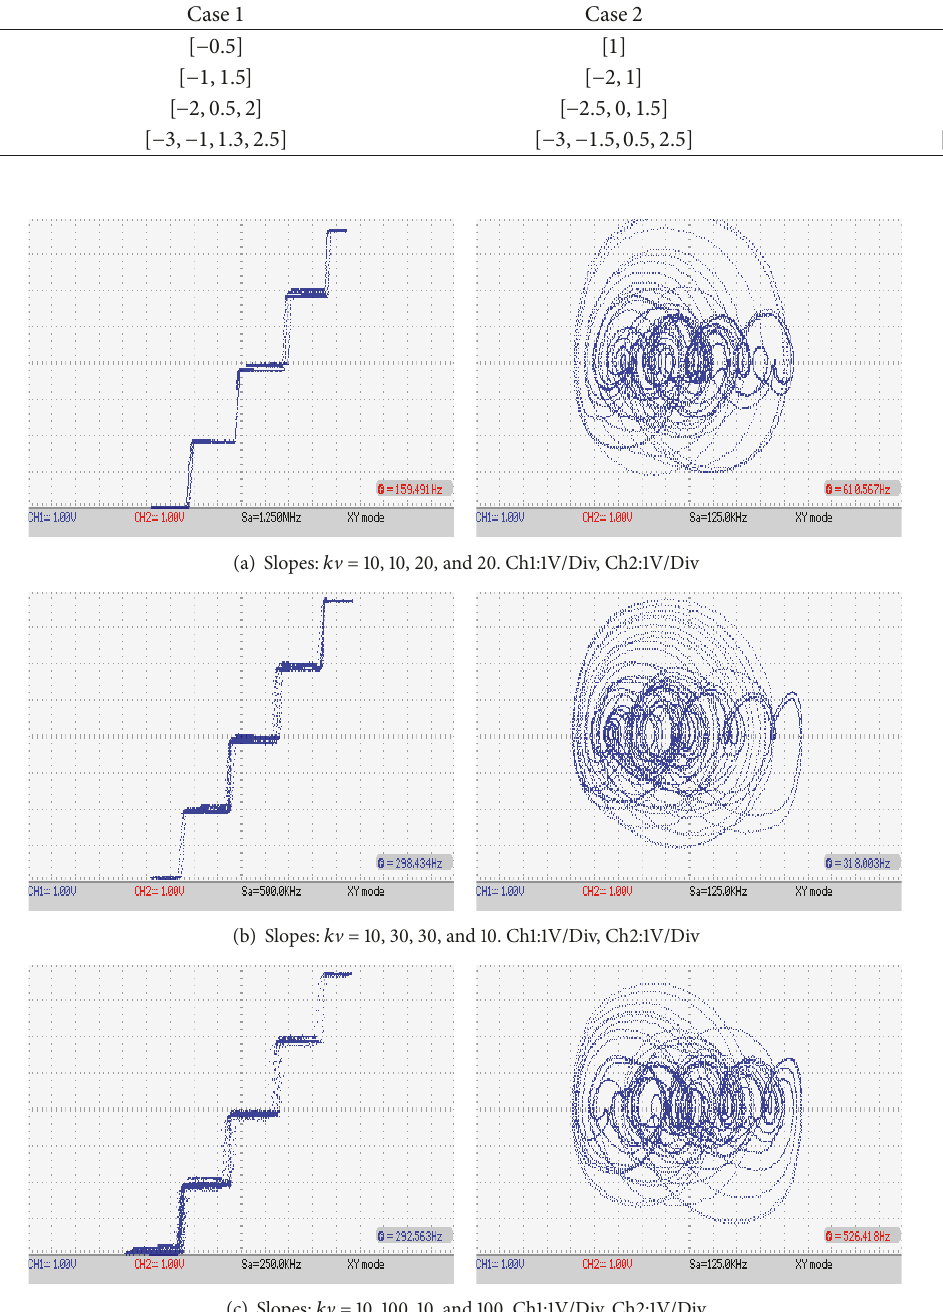
Figure 8: Experimental verification of optimized 5 scrolls using irregular SNLFs with different slopes given in Table 3.